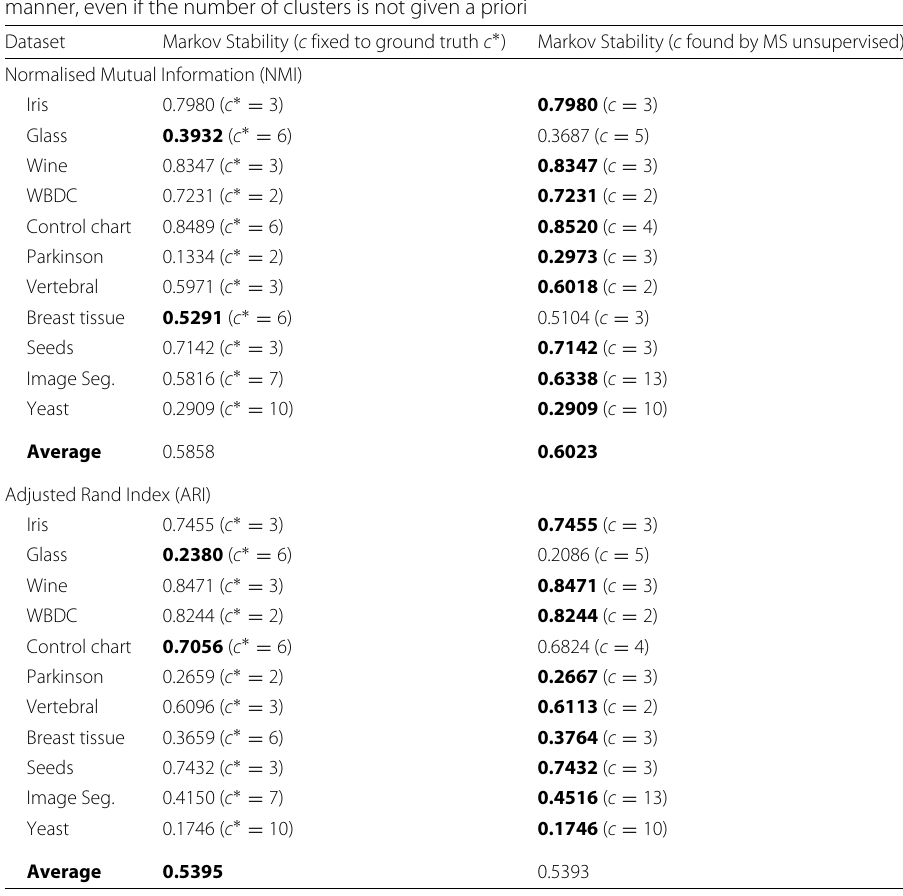
Table 4 Graph-based clustering via Markov Stability performs equally well in a totally unsupervised manner, even if the number of clusters is not given a priori